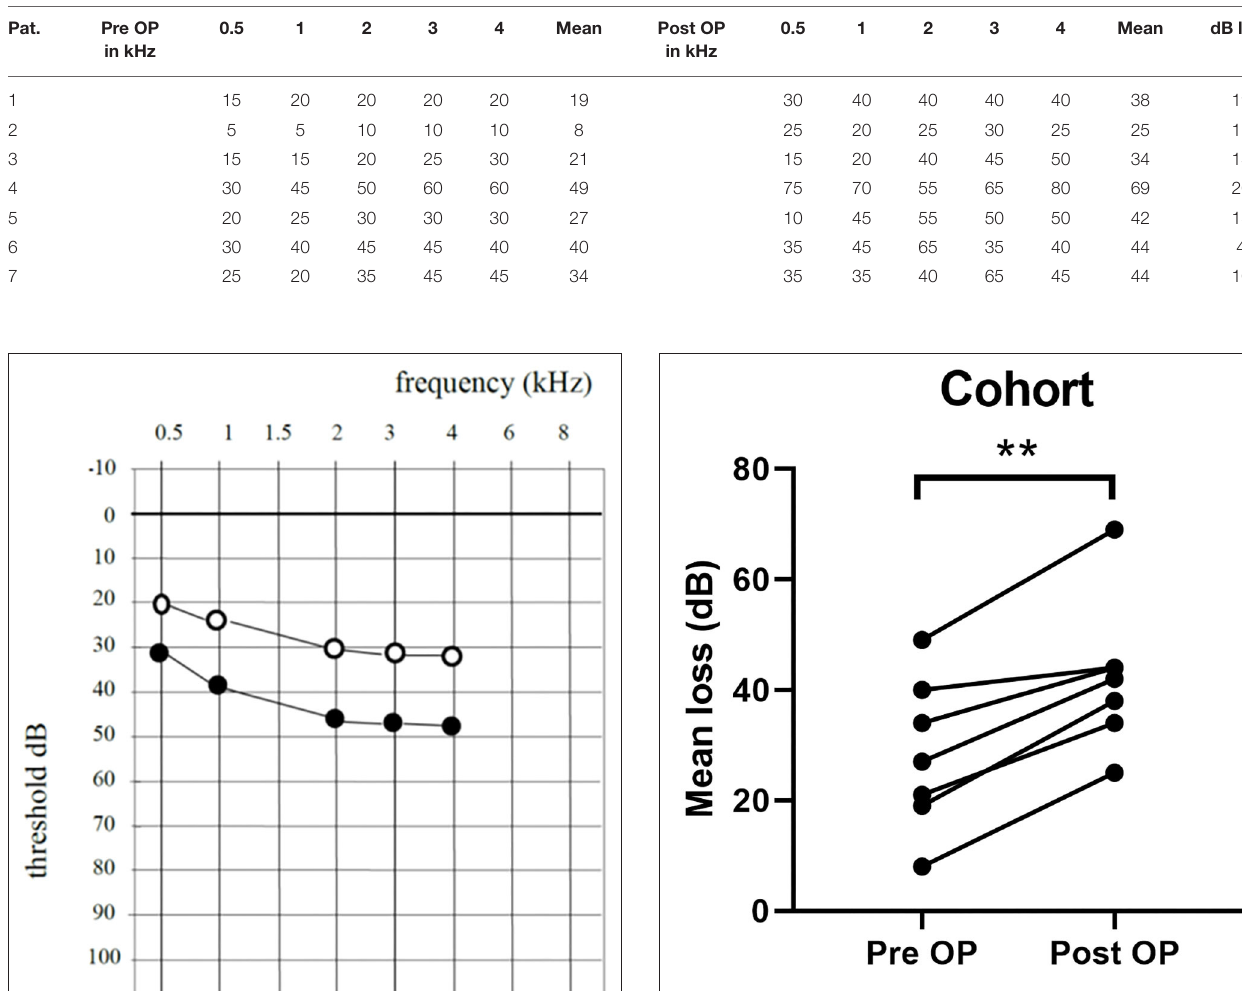
FIGURE 2 | Statistical analysis of cohort group. **indicates a significant